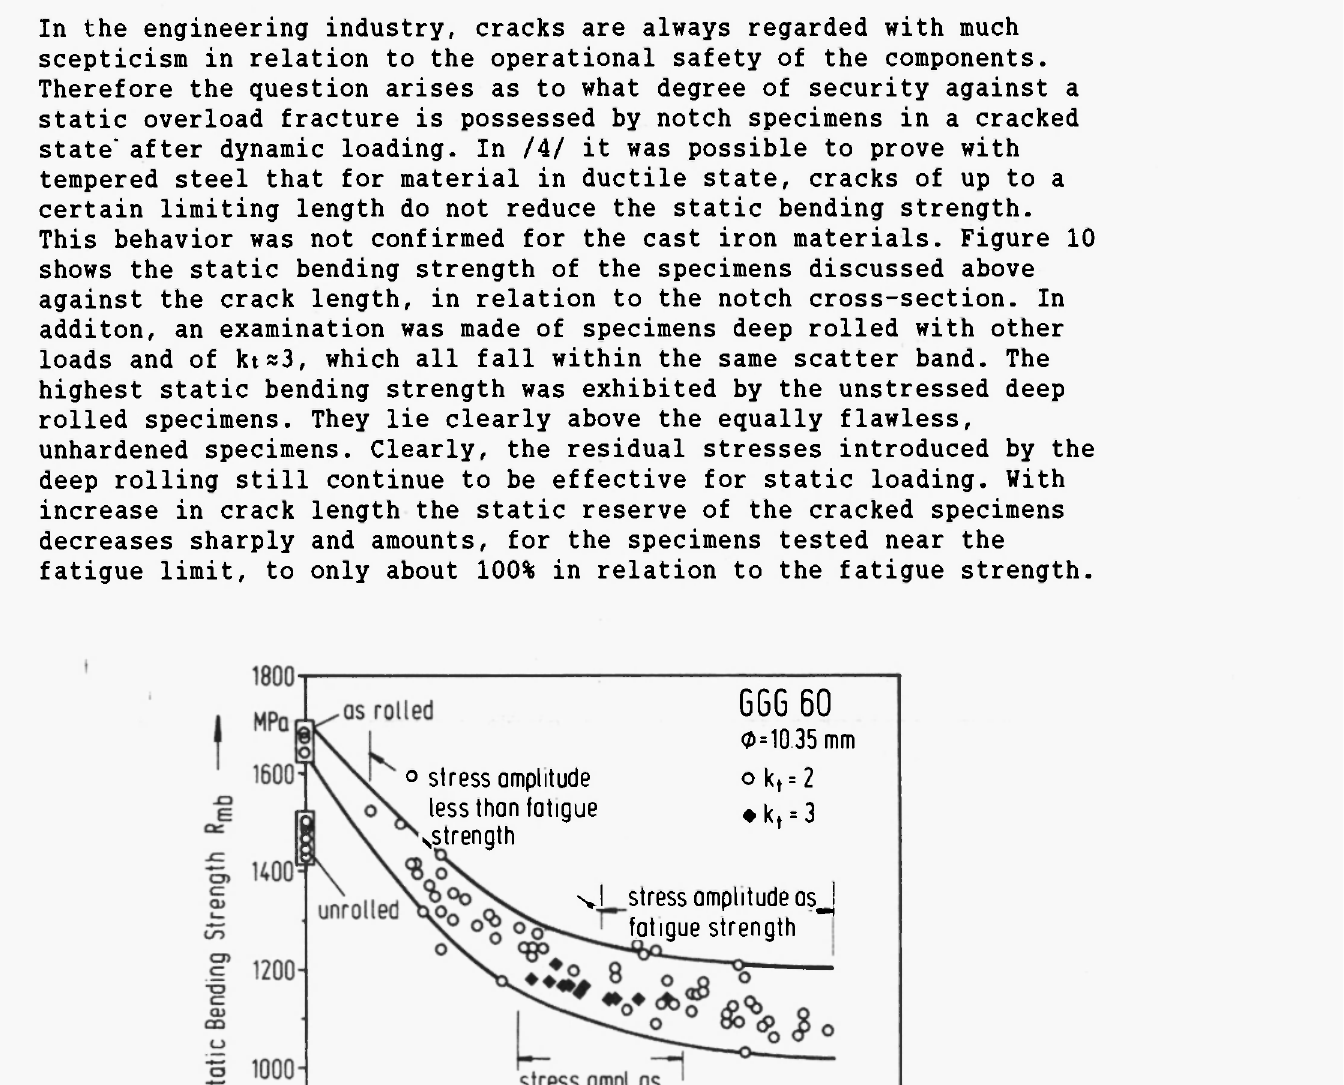
Fig. 10. Influence of crack length on static bending strength of notched nodular cast iron